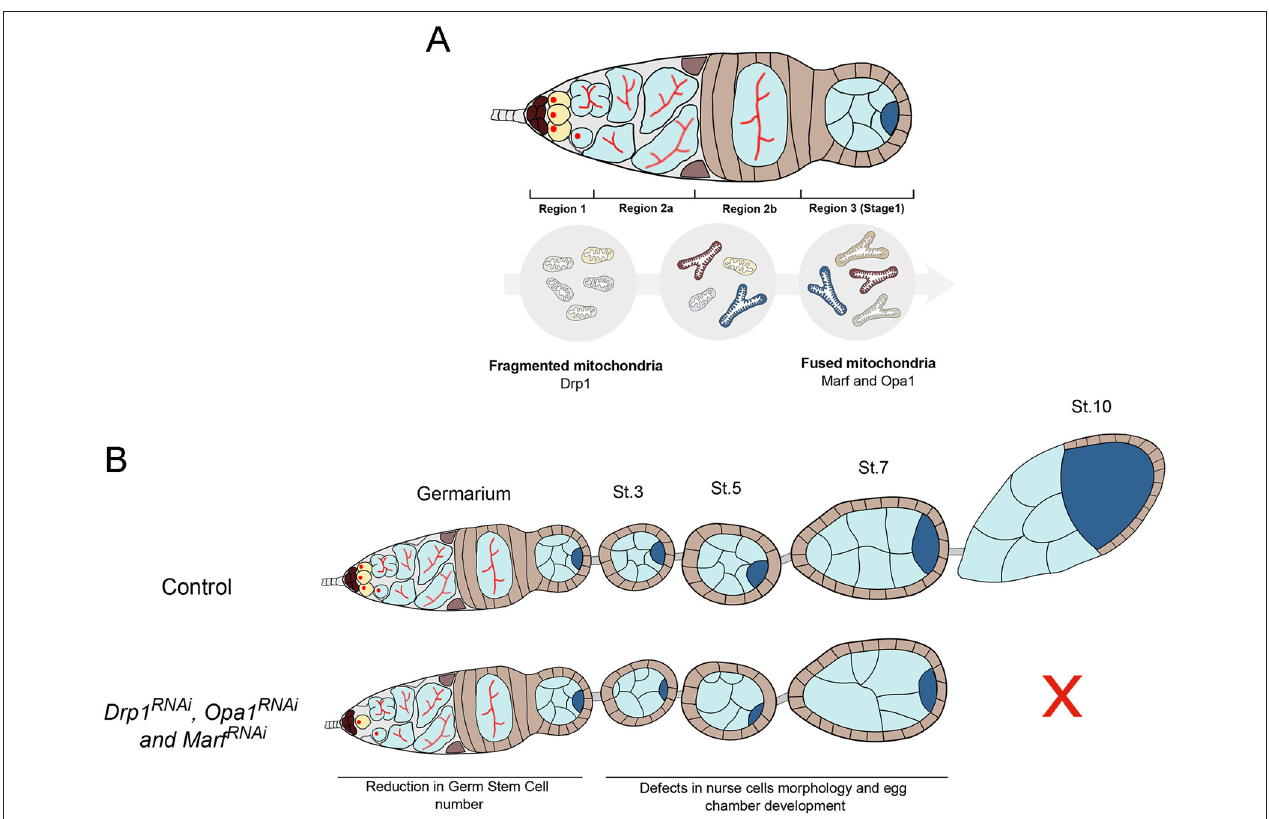
FIGURE 8 | Mitochondrial dynamics is critical for Drosophila GSC maintenance and oogenesis. (A) GSCs in germarium region 1 have predominantly fragmented mitochondria. Throughout germ cell differentiation, mitochondria become more aggregated, indicative of increased fusion. These differential mitochondria morphologies along GSC lineage progression are regulated by fission regulator Drp1 and fusion regulators Marf and Opa1 . (B) Disruption of mitochondrial dynamics, by depletion of fission or fusion regulators in germ cells, causes defective mitochondria morphologies and GSC loss. Defective mitochondrial dynamics in the germline also causes severe defects in egg chambers that contain morphologically abnormal nurse cells and arrest their development before vitellogenic stages. Together, these defects in mitochondrial dynamics in the germline compromise egg chamber formation ultimately resulting in abnormal egg morphologies and reduced female